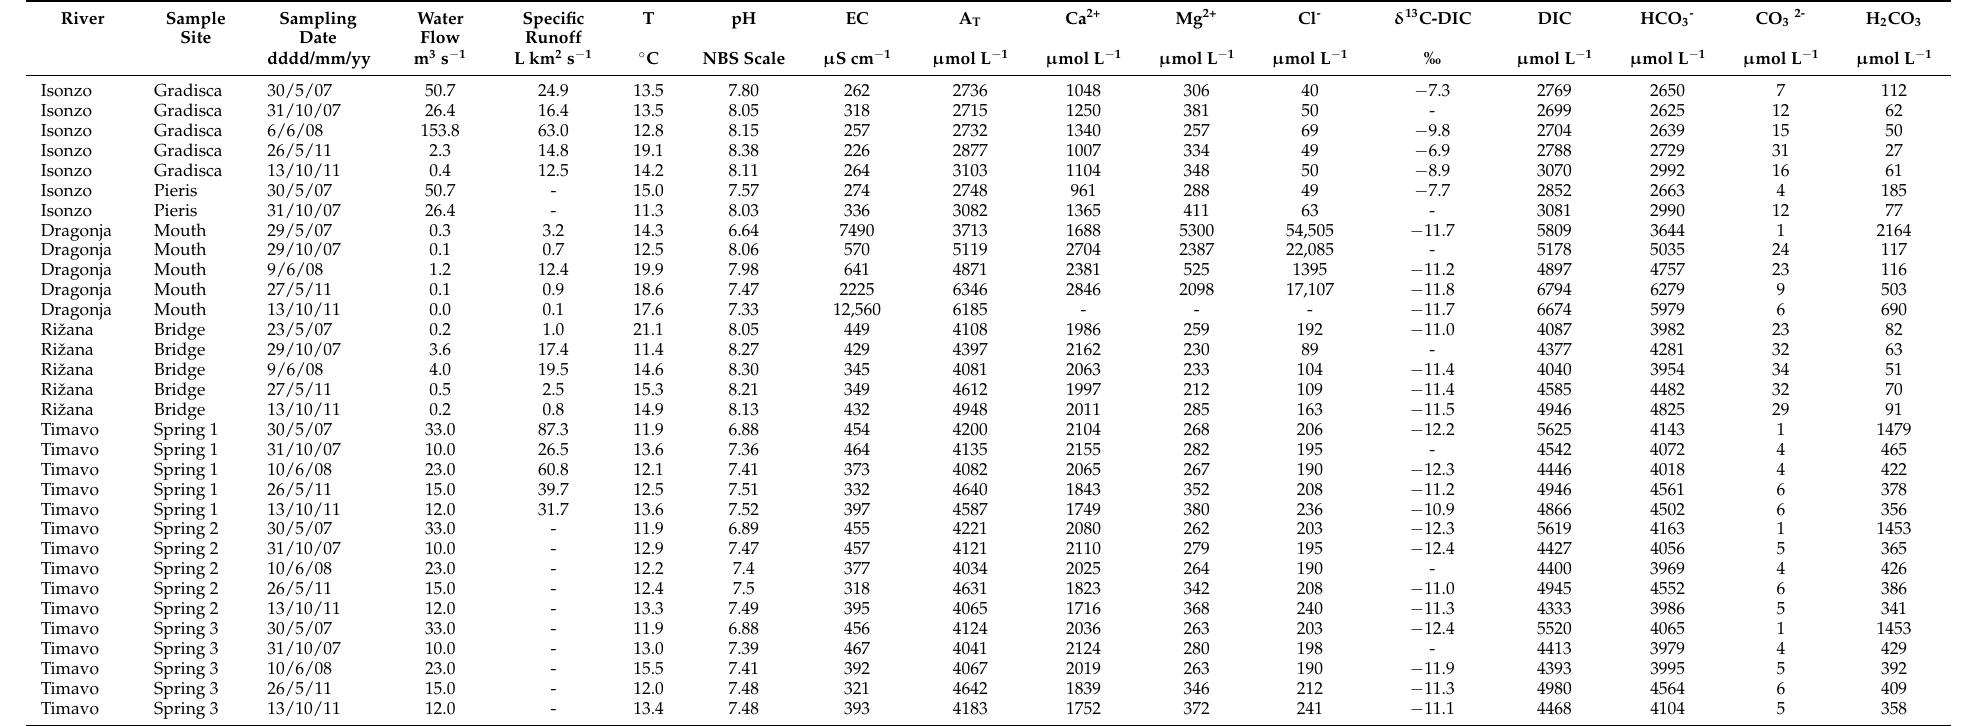
Table A1. Physical and chemical parameters, including δ 13 C DIC , measured in river waters (data source: Jožef Stefan